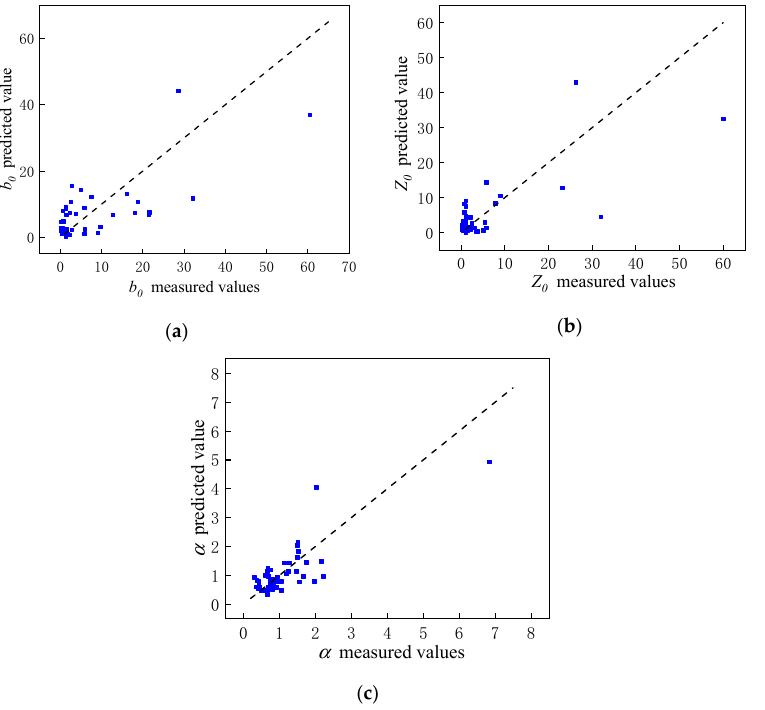
Figure 8. The results of b 0 ( a ); b 1 ( b ) and α ( c ) regression analysis were compared with the measured